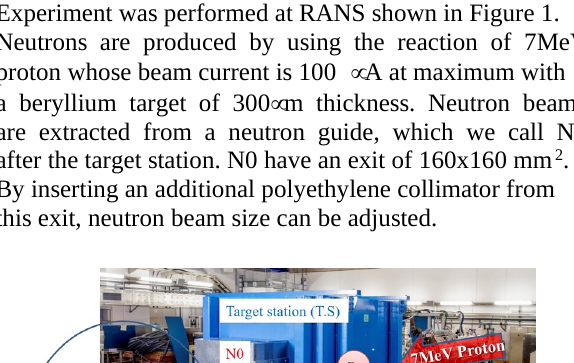
Setup （ I ） det.Ge det.